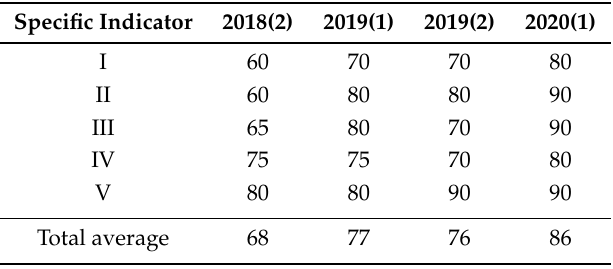
Table 8. Analysis of student performance in the Intelligent Control